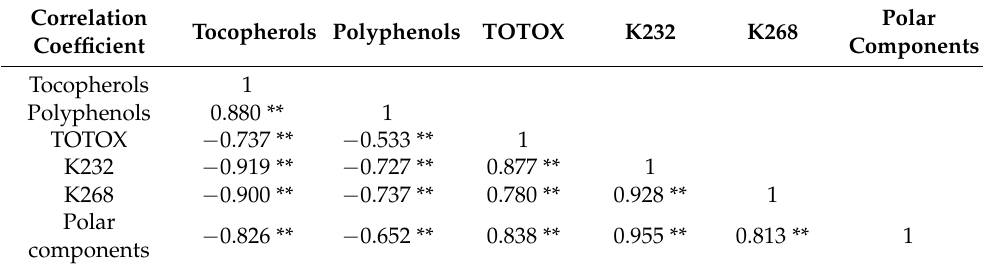
Table 2. Correlation analysis of polyphenols, TOTOX, conjugated alkene, polar components, and tocopherol of camellia oil during